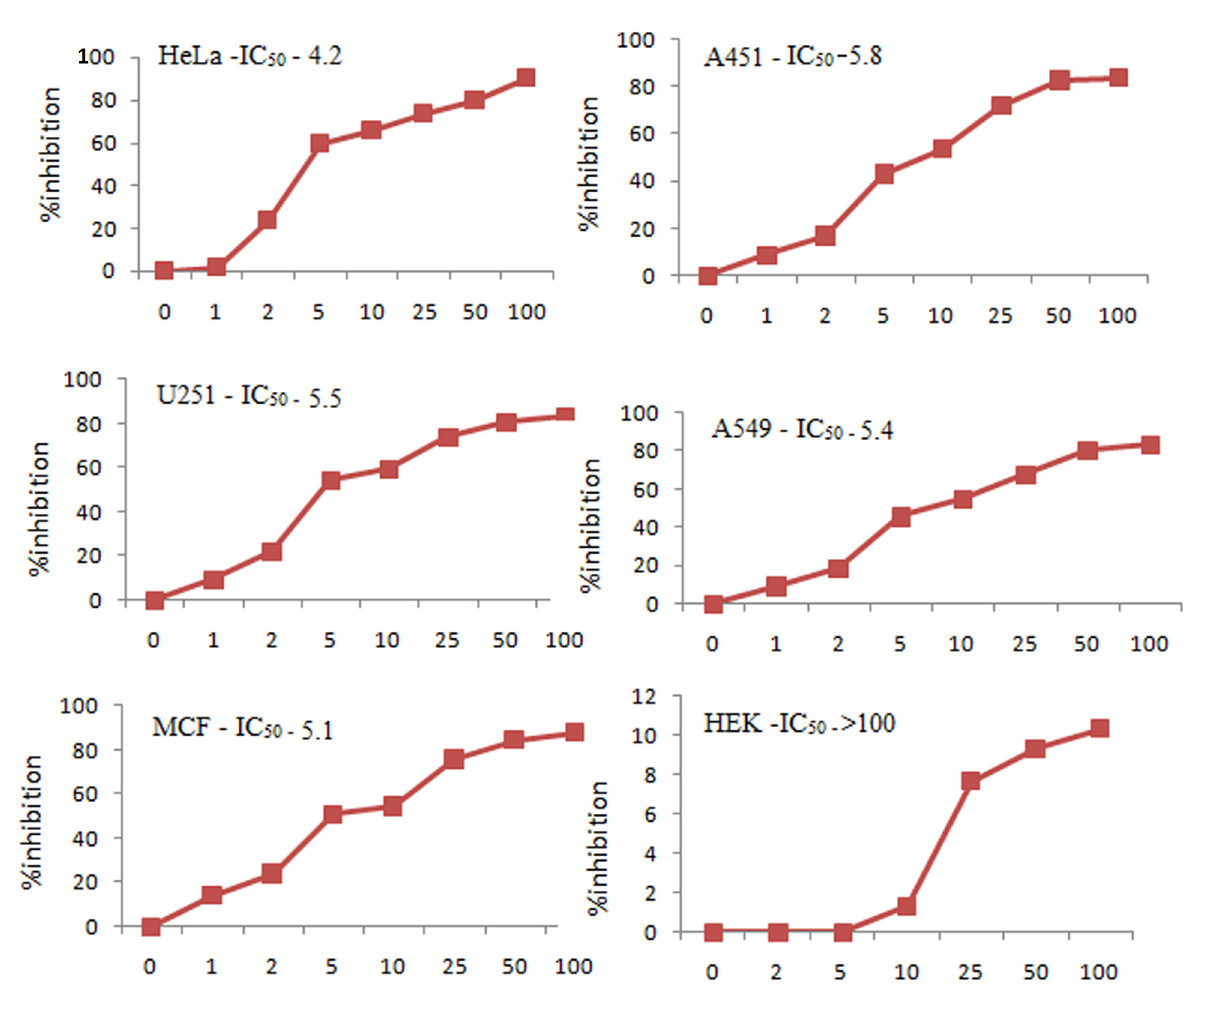
Fig 13. Cytotoxic activity of ‘ fungal VCR ’ in different cancer cell